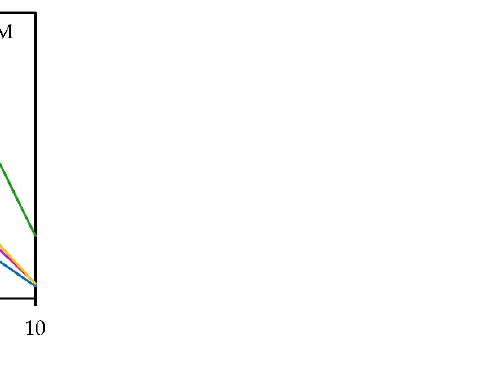
Figure 3. Trends of monthly evapotranspiration at the four observation stations in the Qaidam Basin in 2020.